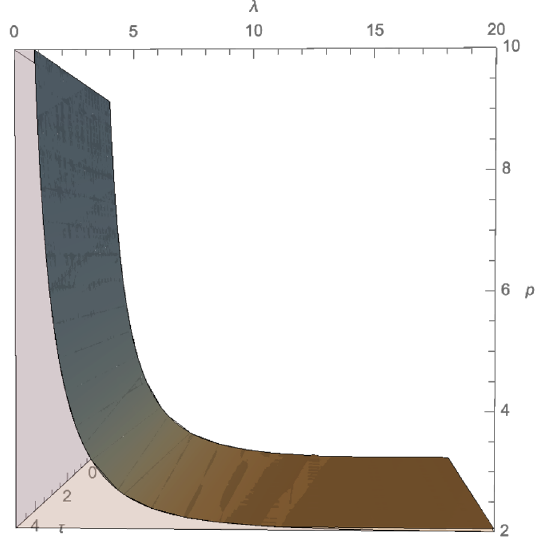
Figure 6 . Schematic plot of the critical surface. The gray region represents the weak cou- pling